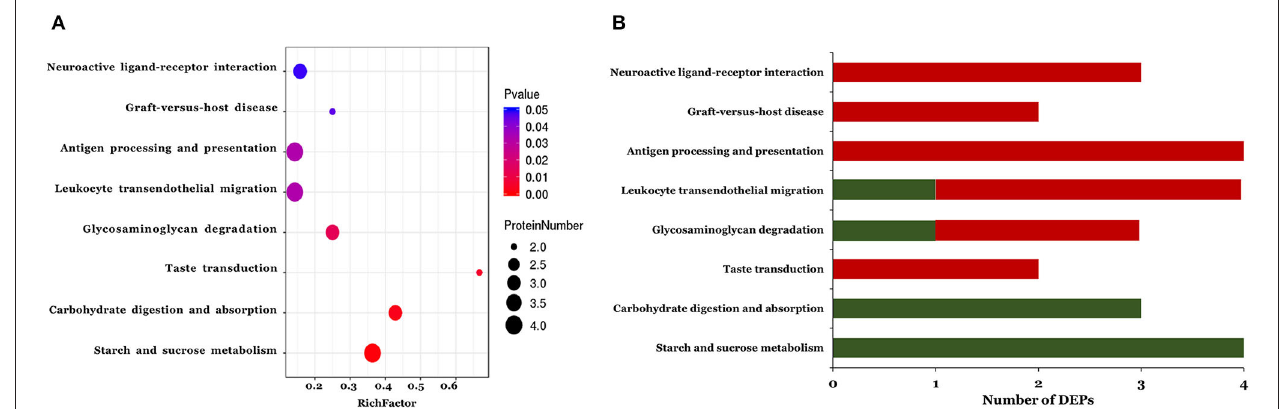
FIGURE 3 | The KEGG pathway enrichment analysis of the differentially expressed proteins. A two-tailed Fisher’s exact test to test the enrichment of the differentially expressed protein. (A) Significantly enriched KEGG pathway; (B) Mapped differential expressed proteins number of KEGG pathway.